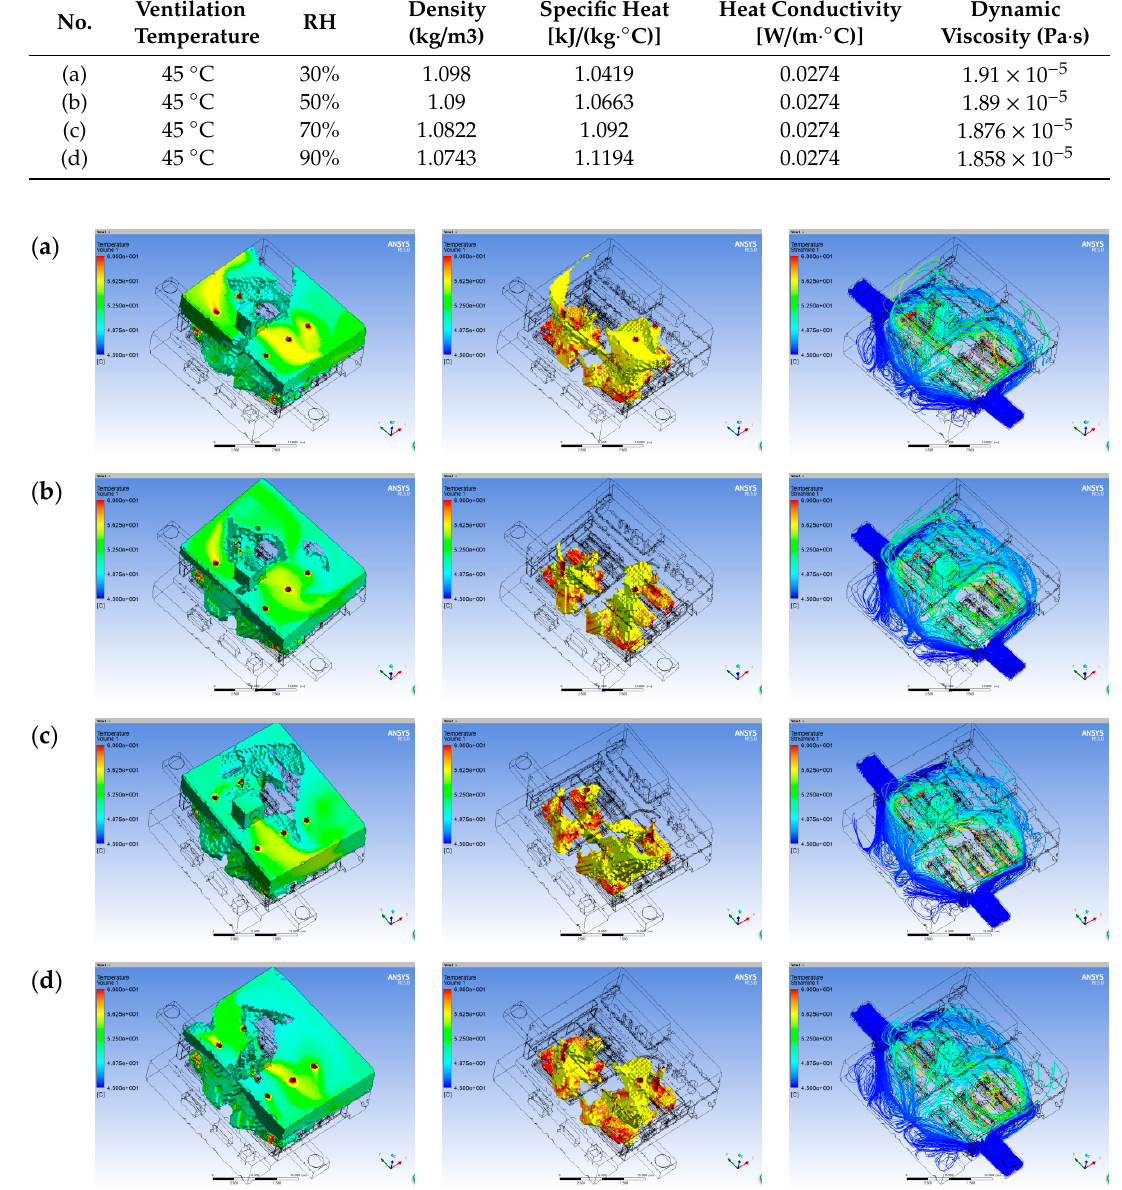
Figure 10. High-temperature volumes above 50 and 55 °C, and temperature streamlines between 45 and 60 °C with different spray cooling settings in Table 5: (a) 30% RH, (b) 50% RH, (c) 70% RH, and (d) 90% RH.